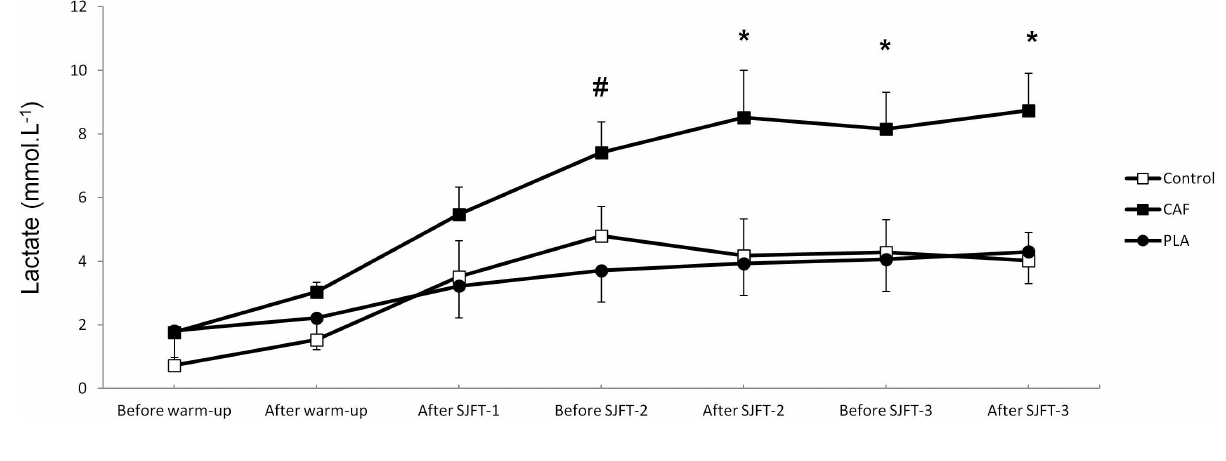
Figure 4. Plasma lactate concentration [La] before and after warm-up, and before and after each bout of SJFT in control and weight loss conditions followed by caffeine (CAF) or placebo (PLA). Data are presented as the mean ± SD. # CAF significantly higher than PLA at the same time point; * CAF significantly higher than control and PLA at the same time